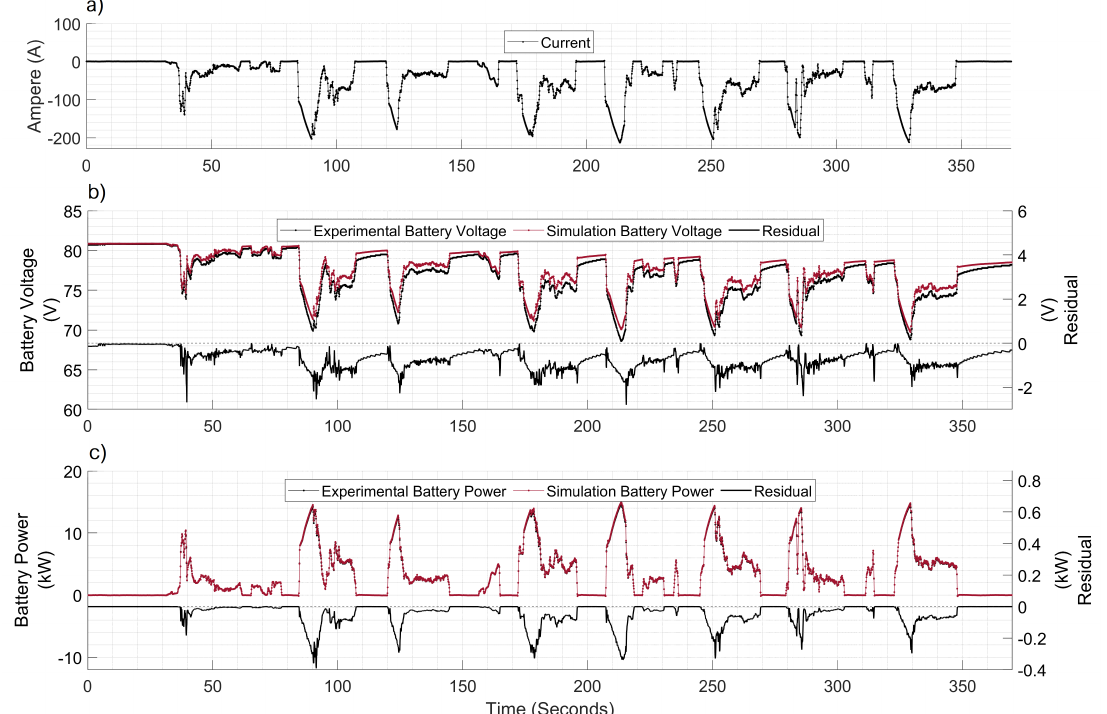
Figure 19. Test #6.4: ( a ) battery pack electrical current (A) as global model input, ( b ) battery pack voltage and ( c ) total battery pack power.